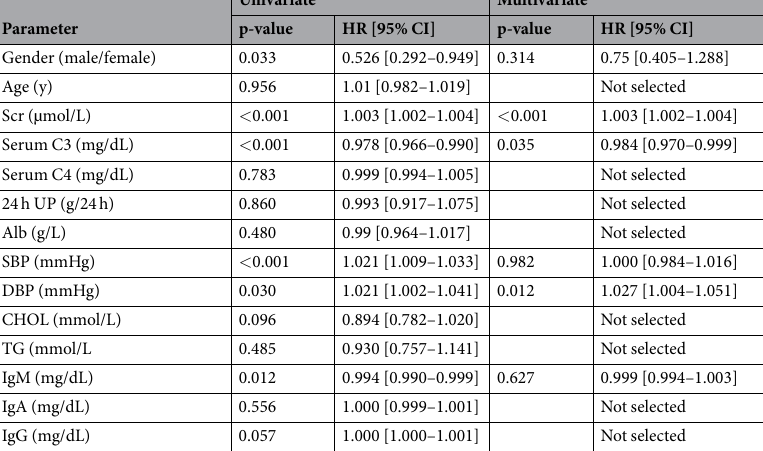
Table 3. Univariate and multivariate analyses of clinical manifestations in Cox proportional hazards model. Scr: serum creatinine; 24 h UP: 24-hour proteinuria; Alb: serum albumin; SBP: systolic blood pressure; DBP: diastolic blood pressure; CHOL: serum cholesterol; TG: serum